Question: Which visualization type does this figure use?
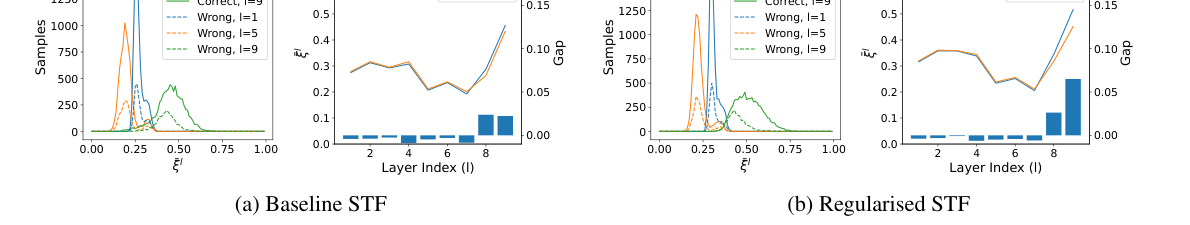
Answer: line